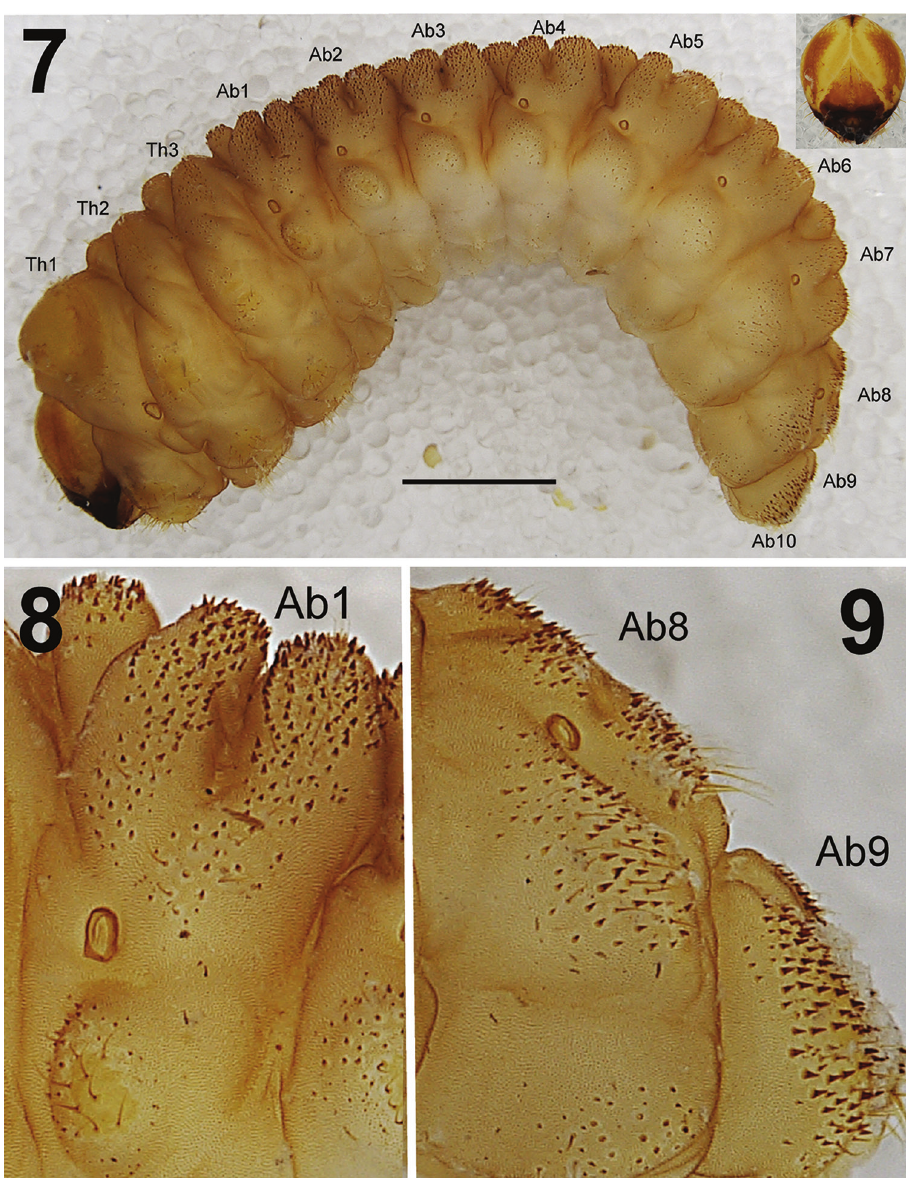
Figure 7–9. Larinus vulpes mature larva. 7 Habitus, lateral view. Scale bar: 2 mm. 8 Detail lateral view on dorsum of abdominal segment I with densely spiculate cuticle 9 Detail lateral view on dorsum of abdominal segment